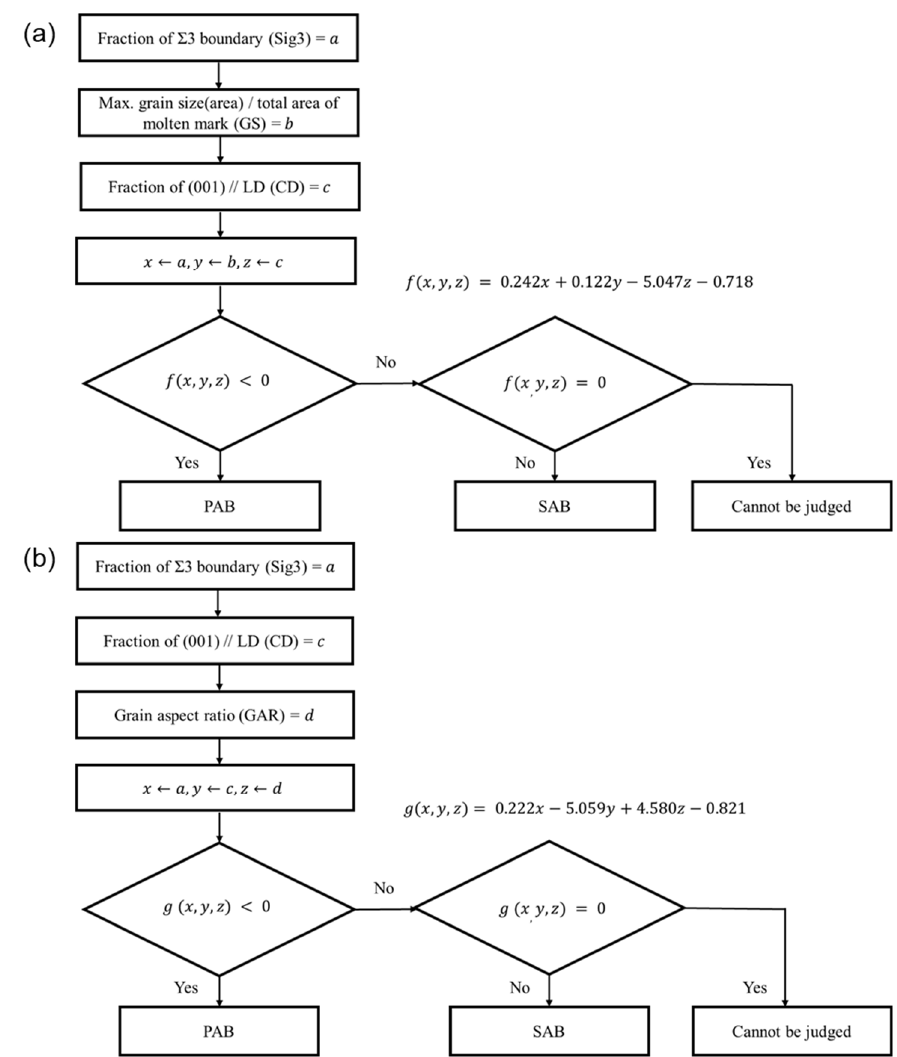
Figure 12. Discriminant process of PABs and SABs: ( a ) Sig3–GS–CD and ( b ) Sig3–CD–GAR.